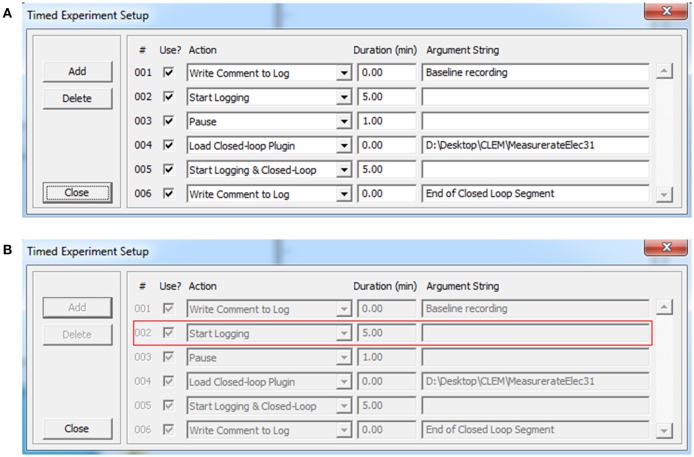
Timed experiments. (A) Automated execution of arbitrary experiment sequences can be carried out programmatically using this dialog box and adding particular actions and their respective durations (up to 200 actions). Actions are selected out of a predefined list that includes, among others, loading plugins, and executing the functions they contain. Arguments can be provided as needed. Experiment sequences can be stored to file and thereafter reused. (B) When the experiment sequence is initiated (Figure 1A, region 1) CLEM steps through the actions and executes them sequentially. The software highlights the action being executed with a red rectangle.